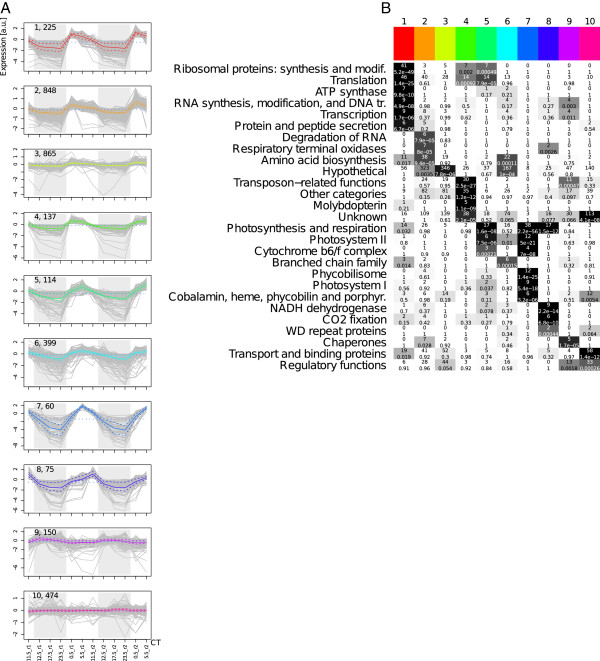
Clustering after LOS normalization yields coarse biological program. The clustering of LOS normalized DFT transformed data using the flowClust approach with ten clusters is shown in panel A. The gray lines represent individual gene profiles, the solid colored line marks the cluster mean profile, and the dashed colored lines mark the 5% and 95% quantiles. For visualization the 12 m transformed data are used. On the upper left corner of every profile plot, the cluster index is given followed by the number of genes in the corresponding cluster. The gray shaded area marks the dark period. The clusters are sorted by the mean phase angle ϕ. A graphical representation of the cluster-wise functional enrichment of the clustering shown in A is presented. The rows of this matrix correspond to biological functions whereas the columns correspond to clusters, where the color marks on the top match the colors used for the cluster mean profiles. The number of genes with the corresponding function is shown on the top of each cell and the enrichment p-value on the bottom. Furthermore, the enrichment p-value is color-coded in the cell background, marking highly significant enrichments in black and non-significant enrichments in white. The rows were rearranged to reveal the temporal ordering.